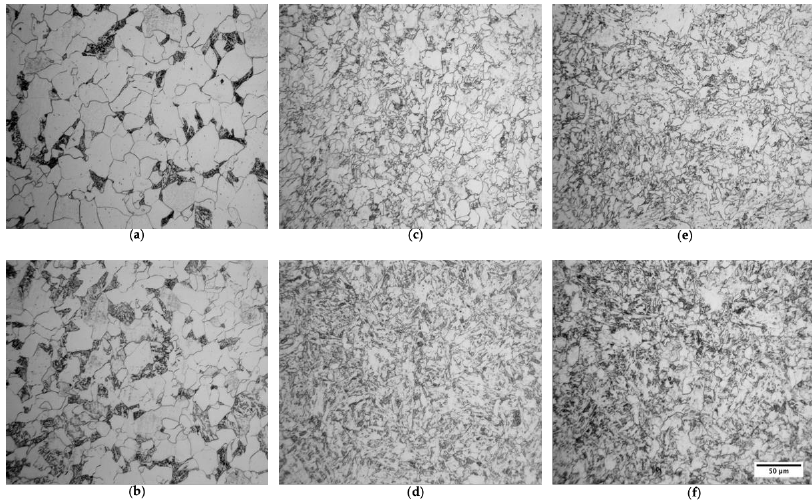
Figure 7. Optical metallographic microstructures of air-cooled samples: ( a ) L0, ( b ) H0, ( c ) L4, ( d ) H4, ( e ) L8 and ( f ) H8.